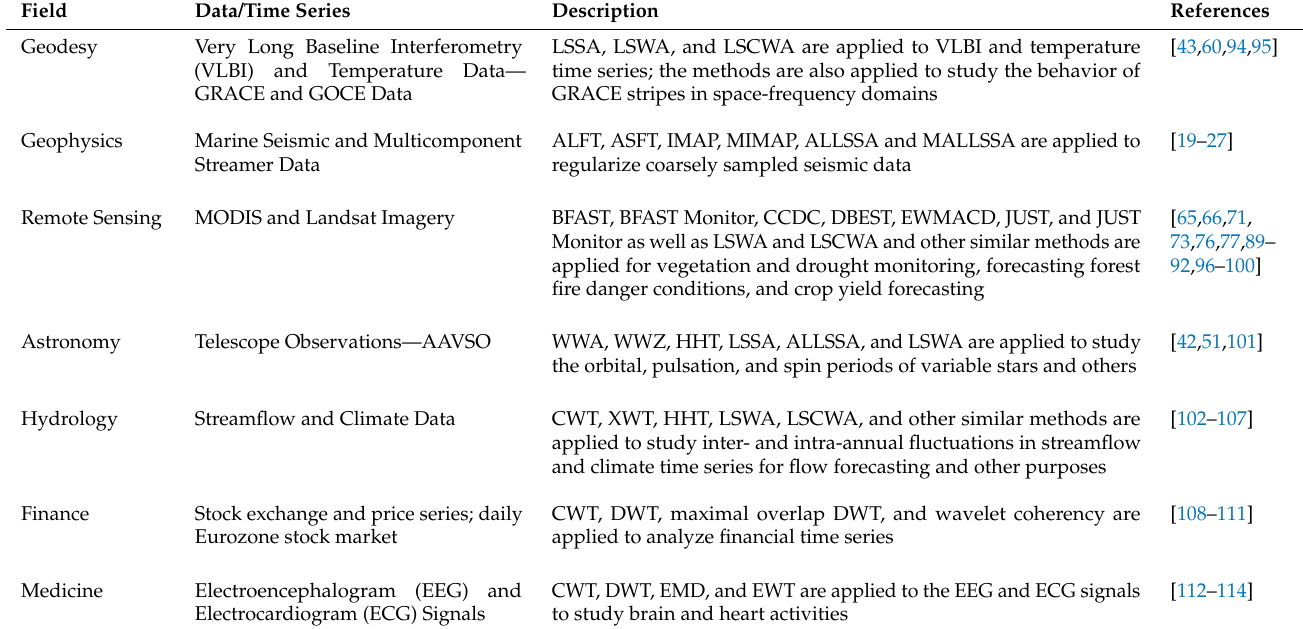
Table 1. Some of the applications of the methods reviewed in this